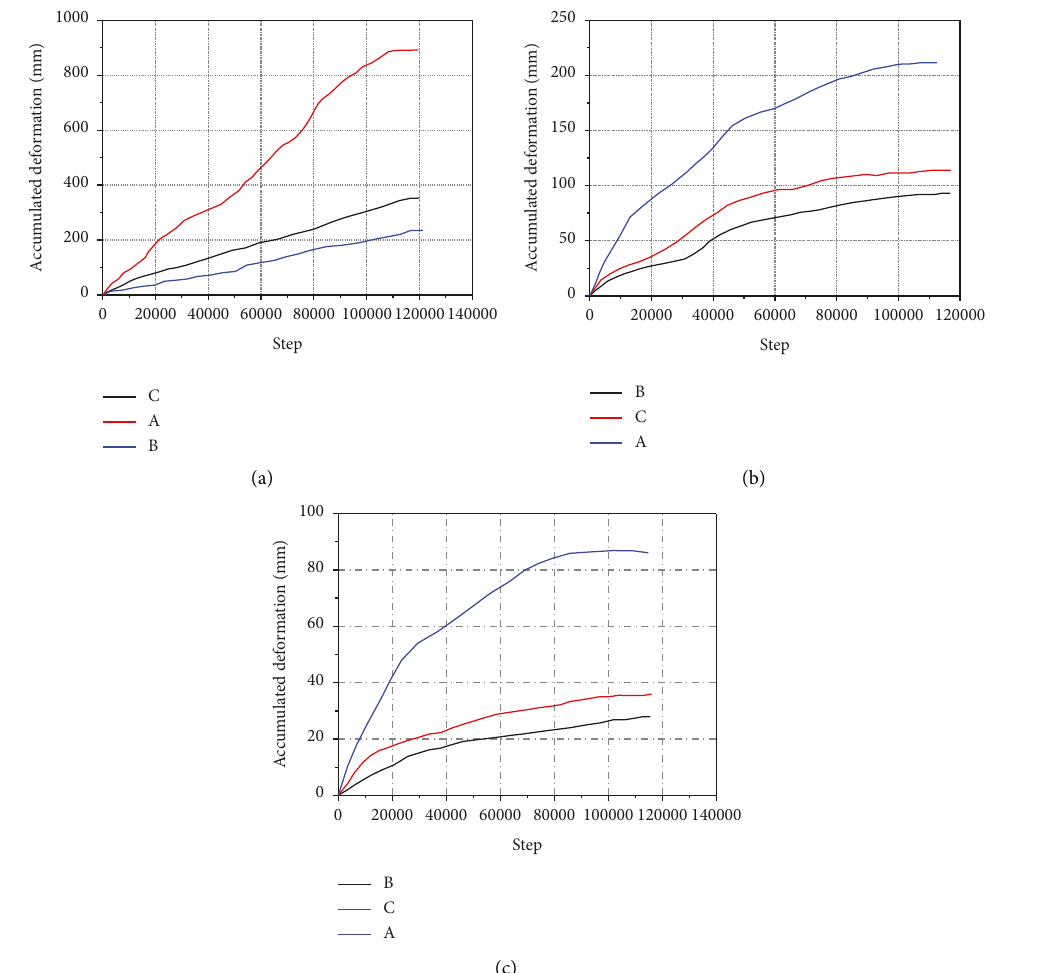
Figure 10: Contrast of monitoring curves, (a) original support system, (b) high prestressed constant resistance coupling support system, and (c) dual-control constant-resistance coupling control system.